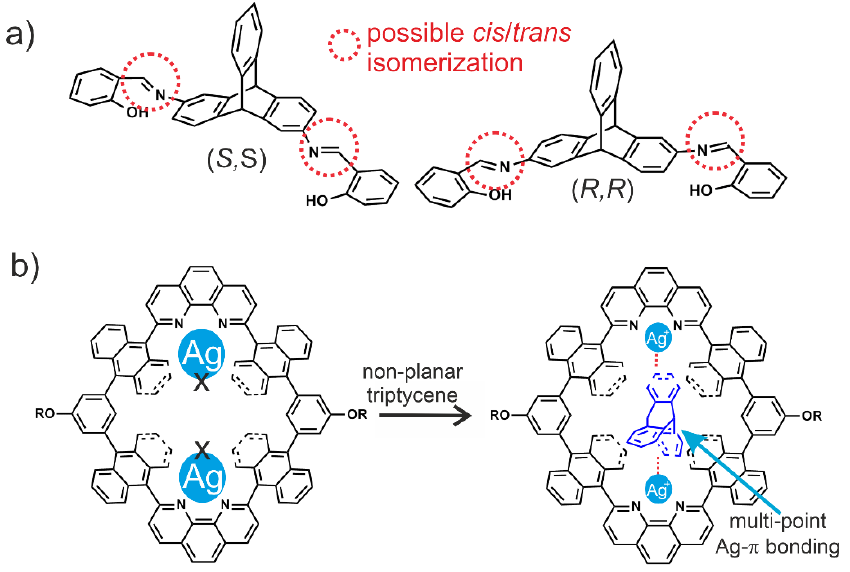
Figure 4. ( a ) The triptycene derivative with imine C=N bonds, which can induce isomerism [160]. ( b ) A host–guest system in which a multipoint Ag–π bonding facilitates recognition of a triptycene ( b ) A host–guest system in which a multipoint Ag– π bonding facilitates recognition of a triptycene molecule by a Ag(I)-containing macrocyclic host [161]. molecule by a Ag(I)-containing macrocyclic host